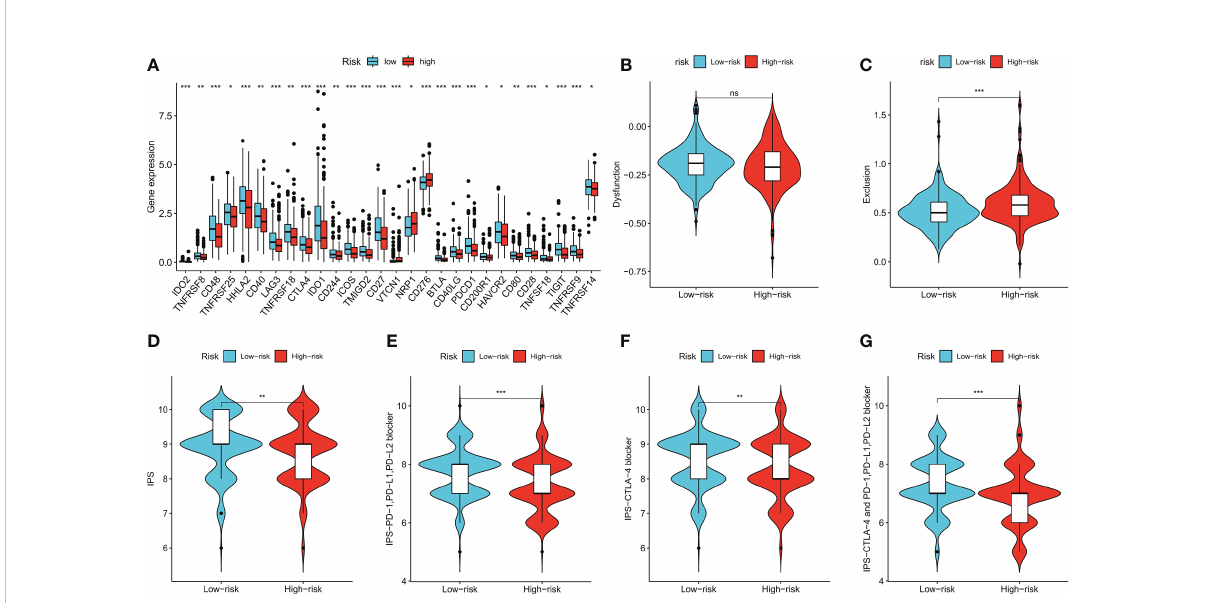
FIGURE 8 Immune checkpoint genes expression, TIDE score and IPS of patients in two risk groups. (A) The differences of immune checkpoint gene expression in high-risk and low-risk groups. (B, C) Violin plots showed the relationship between TIDE score and risk groups. (D – G) Violin plots showed the relationship between IPS and risk groups. * p < 0.05; ** p < 0.01; and *** p < 0.001. ns p >